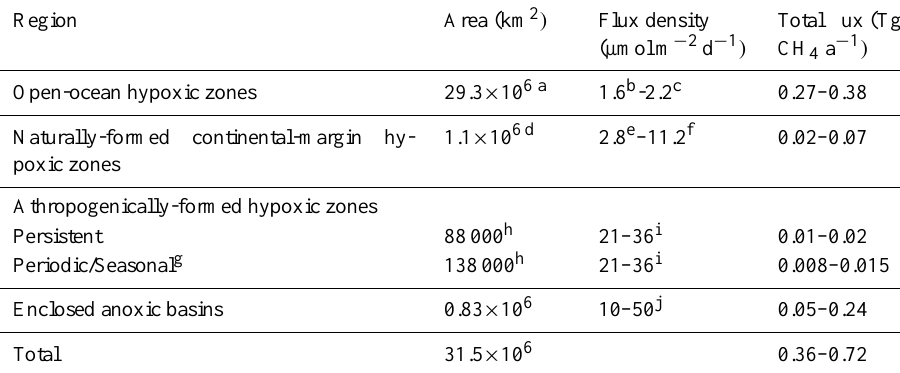
Table 3a. Total CH 4 emissions from various types of marine O 2 -deficient systems.